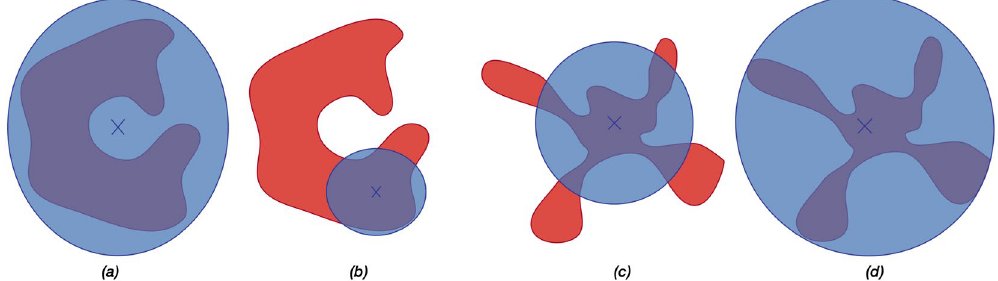
Figure 2. Illustration of the effect of different hitting probabilities on a feasible region. ( a ) Low hitting probabilities may lead to infeasible design centers. ( b ) Increasing the hitting probability (e.g. shrinking the proposal) leads to a feasible design center. ( c ) For volume estimation, high hitting probabilities may under- estimate the volume. ( d ) Decreasing the hitting probability leads to better volume